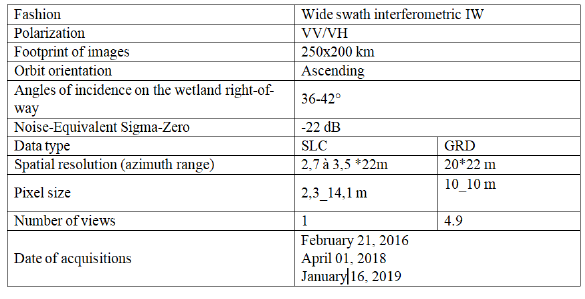
The permanent water polygons and the permanent emergent zones were drawn by photo-interpretation. The Water class polygons have been delineated on optical imagery, which is assumed to be closer to reality. The polygons of the other class were drawn by photo-interpretation using all the radar images: areas with low backscattering (which could be mistaken for water) and were systematically taken into